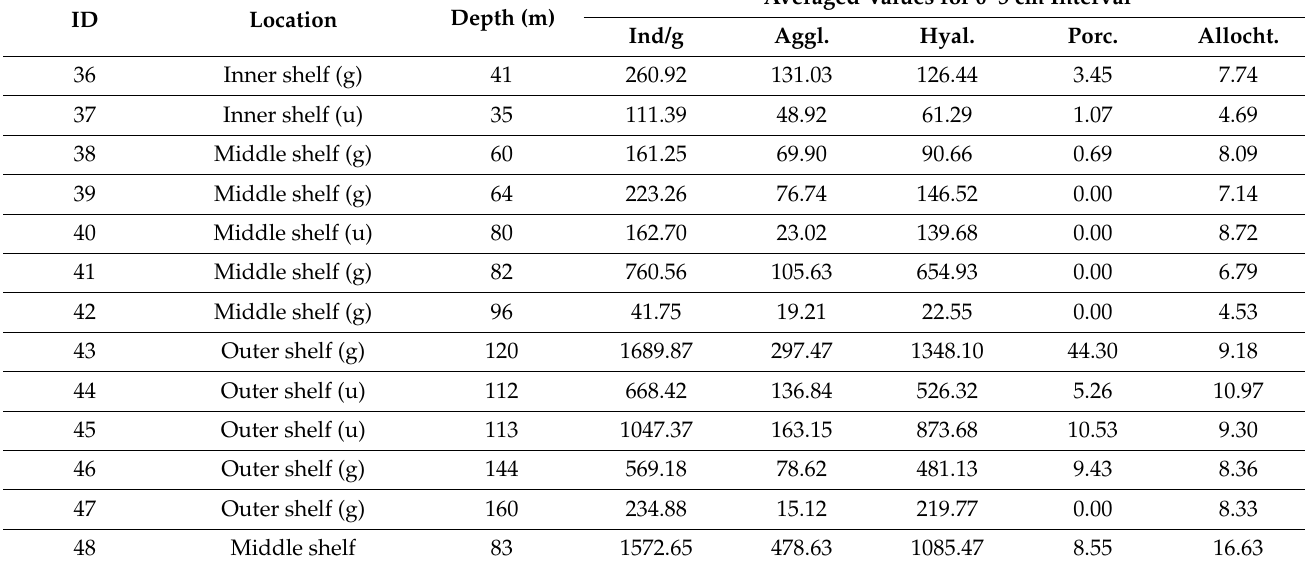
Table 4. Summary of dead foraminiferal data for the analyzed samples in the first 5 cm. (g) gullies; (u) seafloor undulations; (s) slightly. Density (ind/g), proportion of agglutinated (Aggl.), hyaline (Hyal.), porcelanaceous (Porc.) and allochthonous (Allocht.) taxa (expressed as ind/g) are reported for each